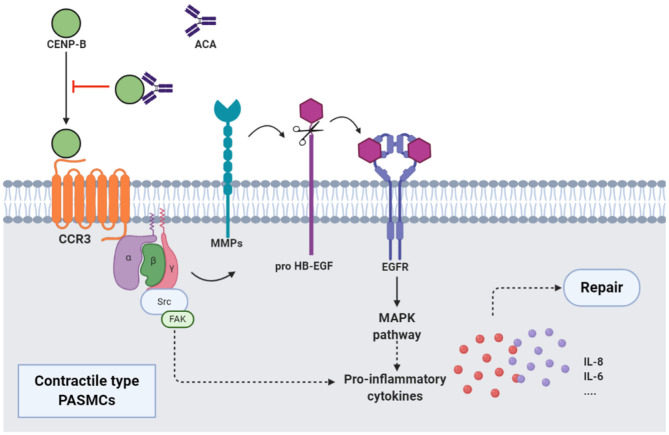
ACAs and CENP-B: CENP-B bound to CCR3. Then, the cross-talk between CCR3 and EGFR, which was mediated by the MMPs-dependent processing of pro HB-EGF, activated MAPK pathway, and production of proinflammatory cytokines such as IL-8, and promoted the migration of contractile-type PASMCs, further leading to vascular self-repair. ATAs from patients with SSc, when combined with CCR3-binding CENP-B, abolished the abovementioned pathway and inhibited the vascular self-repair. EGFR, epidermal growth factor receptor; MMP, matrix metalloproteinase; HB-EGF, heparin-binding EGF-like growth factor; MAPK, mitogen activated protein kinase.